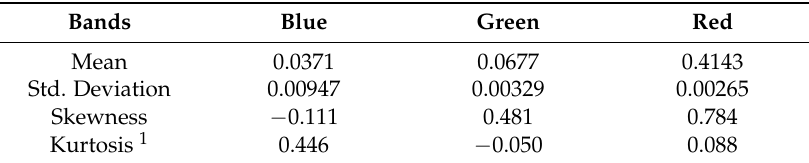
Table 3. Statistics of the Diffuse Attenuation Coefficients